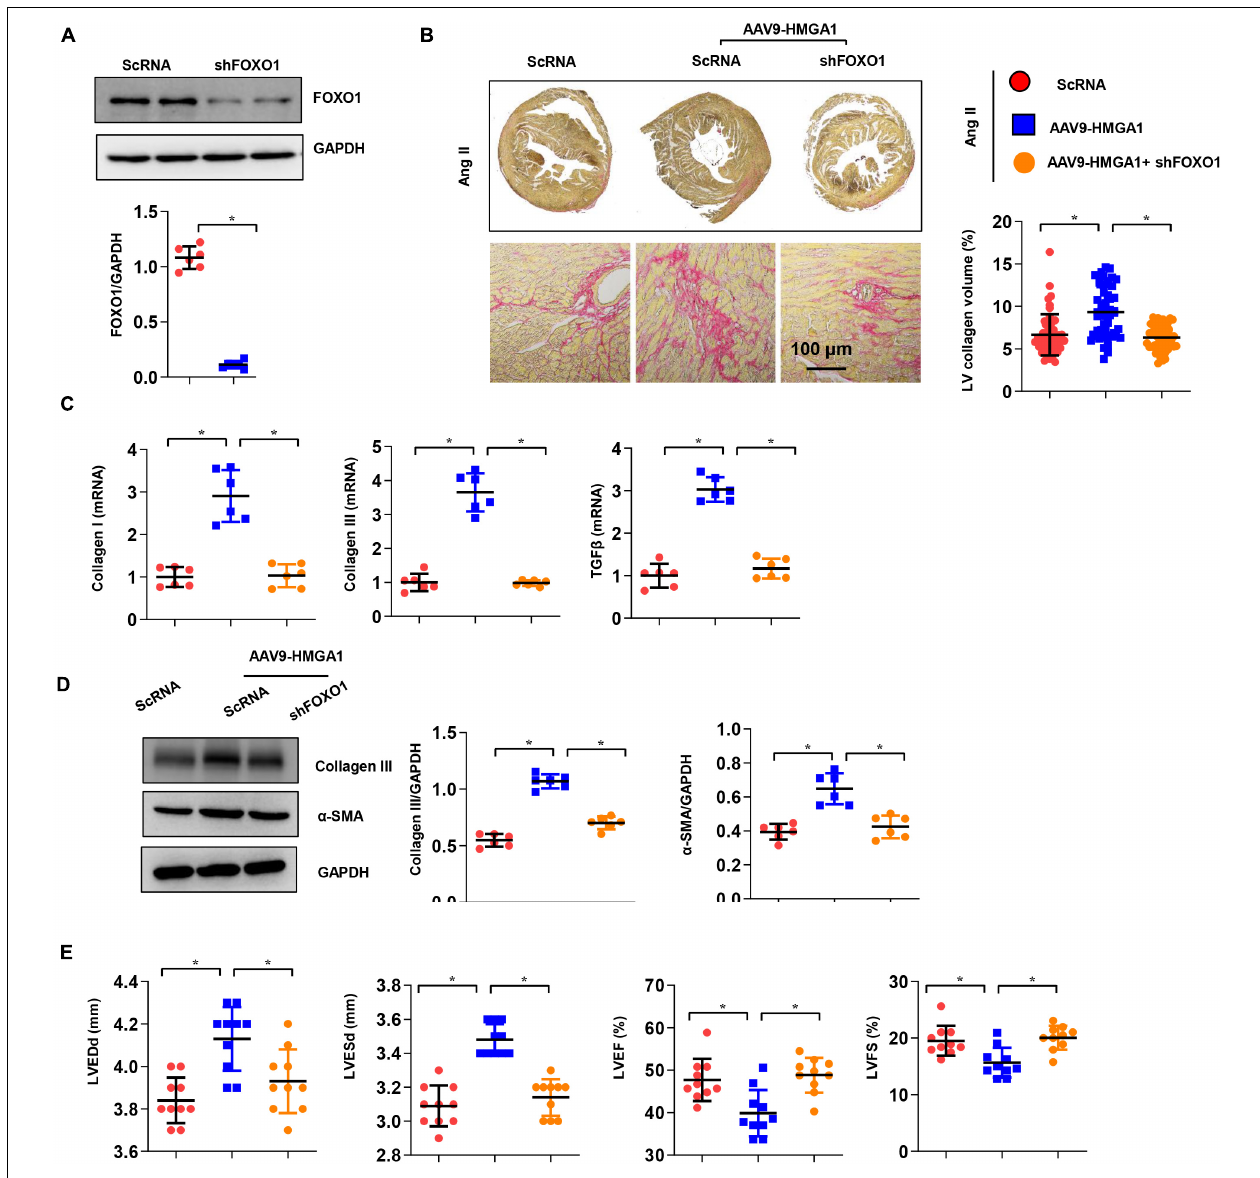
FIGURE 8 | FOXO1 inhibition attenuated HMGA1-induced cardiac dysfunction. (A) The protein level of FOXO1 in mouse hearts 3 weeks after AAV9-shFOXO1 injection ( n = 6). (B) PSR staining image and quantitative result of left ventricular collagen volume in mouse hearts 28 days after Ang II infusion ( n = 5). (C) Transcription levels of collagen I, collagen III, and TGF β 1 ( n = 6). (D) Protein levels of collagen III and α -SMA in heart tissue ( n = 6). (E) Echocardiographic results in each group ( n = 10). * p <